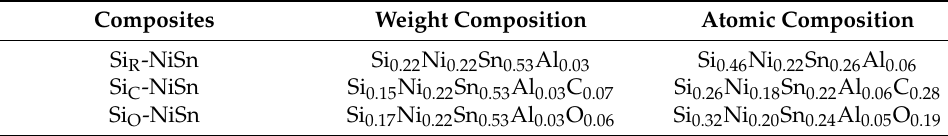
Table 1. Compositions of Si R -NiSn, Si C -NiSn and Si O -NiSn composites. Composites Weight Composition